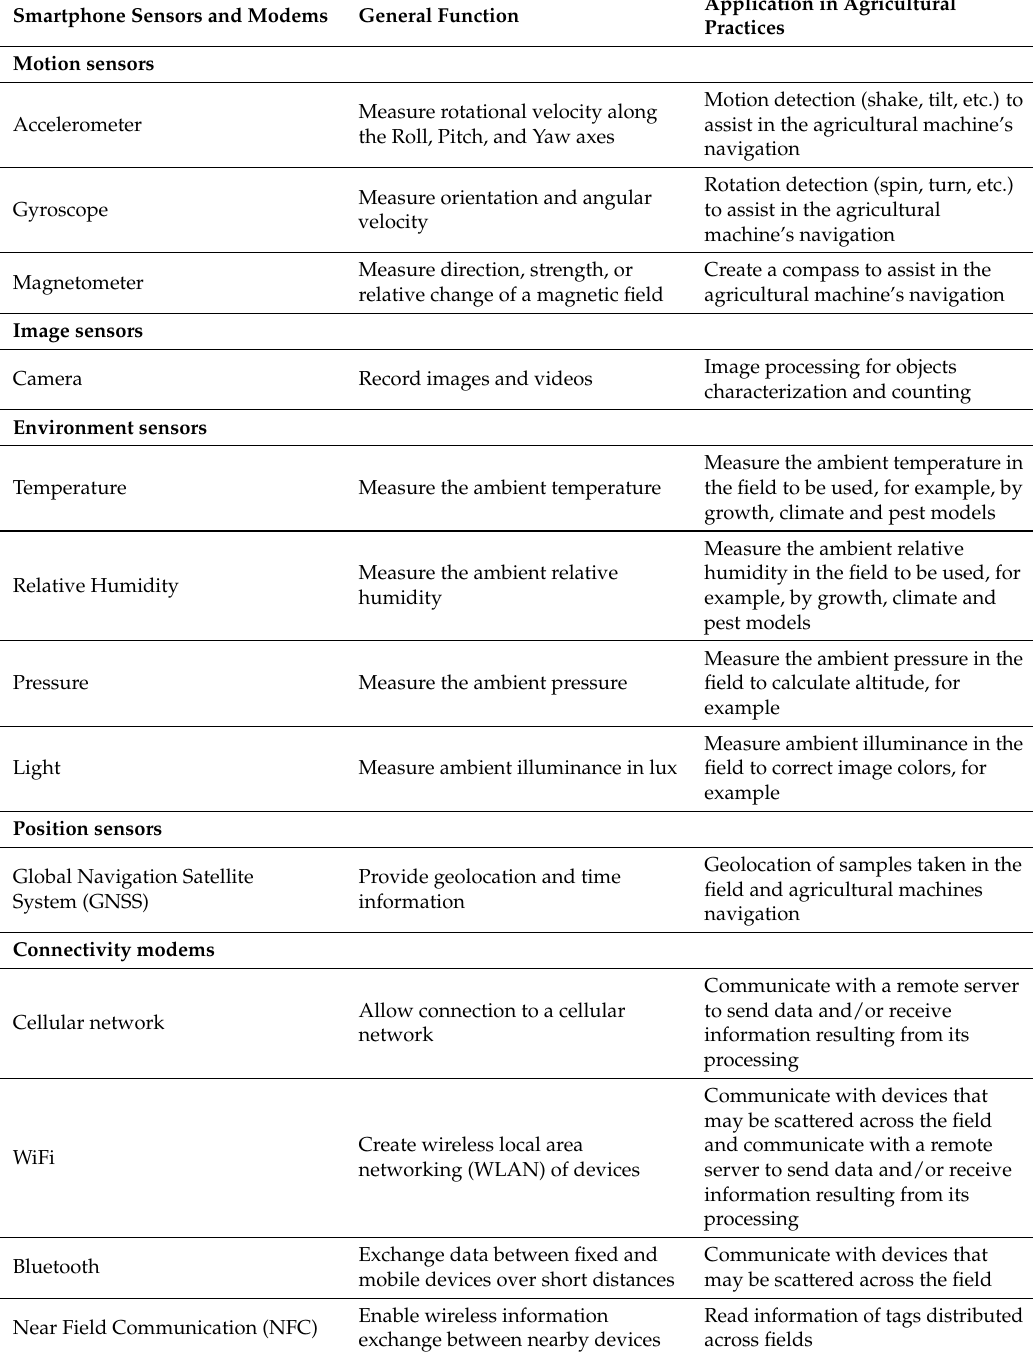
Table 2. Main built-in smartphone sensors and connectivity